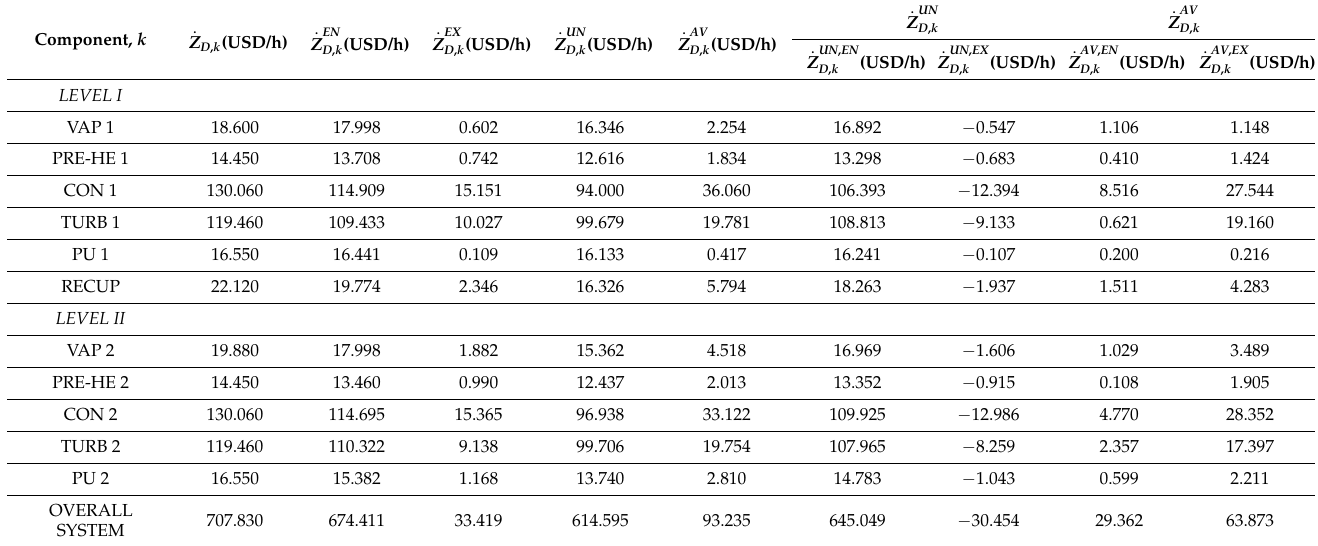
Table 7. Results of the AdvExEcon analysis for the investment cost rates of all the